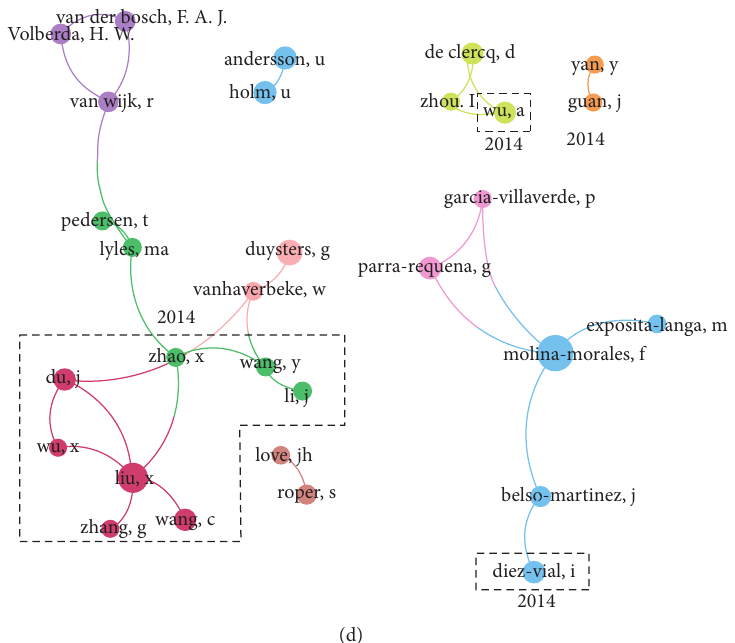
Figure 4: On time-varying authors’ collaboration networks (1994–2018), taking into account 5 or more scientific documents in common. Source: own elaboration with Web of Science and Scopus data (2018) processed with VOSviewer software. (a) T 1 � 1994–2007, N 1 � 7, G 1 � 3; (b) T 2 � 1994–2009, N 2 � 11, G 2 � 5, GN 2 � 2, GA 2 � 0, GJ 2 � � 2; (c) T 3 � 1994–2012, N 3 � 18, G 3 � 7, GN 3 � 2, GA 3 � 1, GJ 3 � 0; (d) T 4 � 1994–2016, N 4 � 30, G 4 � 9, GN 4 � 2, GA 4 � 2, GJ 4 � 5. T � time period; N � number of nodes; G � number of groups; GN � number of new groups; GA � number of amplified group; GJ � number of groups